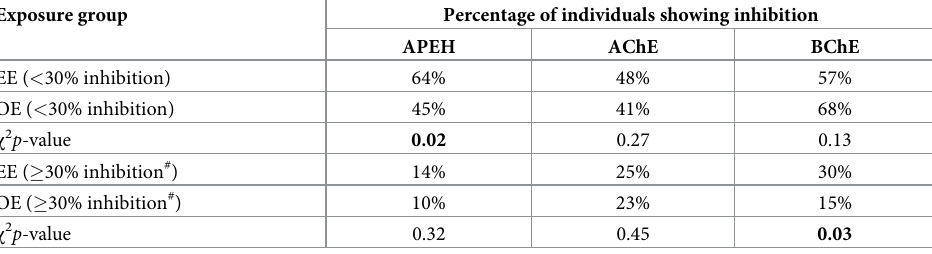
Table 3. Frequency of individuals showing enzyme activity inhibition during spraying. Exposure